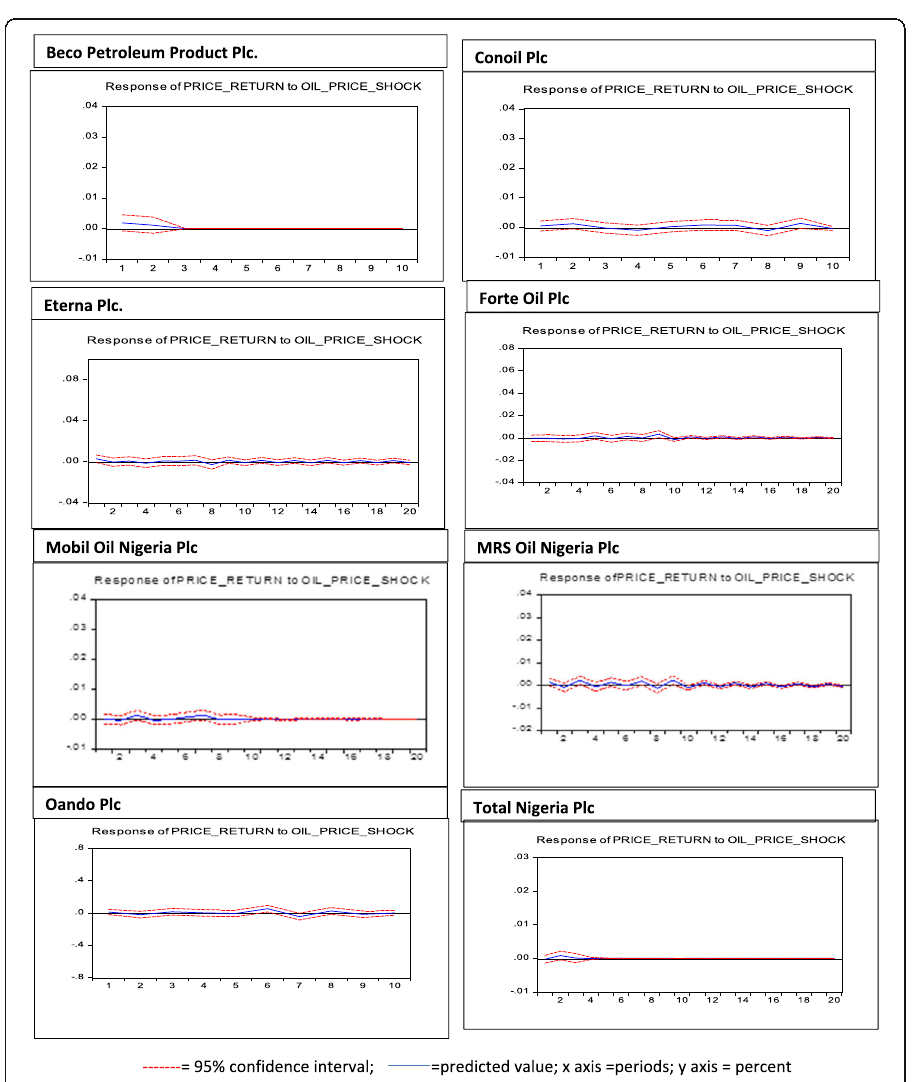
Fig. 1 Impulse response of stock price return to oil price shock per